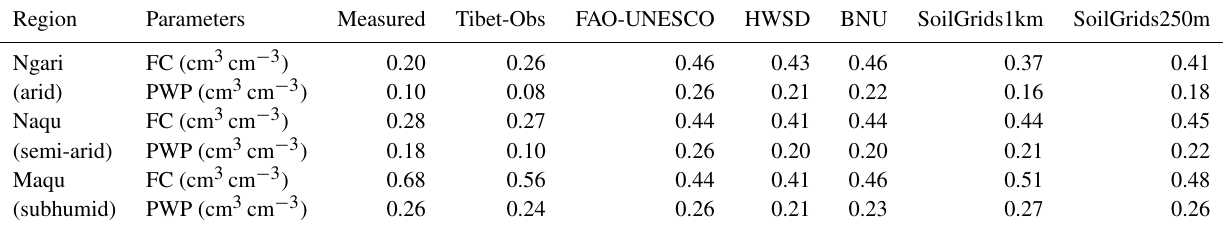
Table A6. Comparisons of the mean derived FC and PWP from SWRCs–CH and SWRCs–VG models based on various soil datasets, with the laboratory measurements. FC represents field capacity, and PWP denotes the permanent wilting point. Region Parameters Measured Tibet-Obs FAO-UNESCO